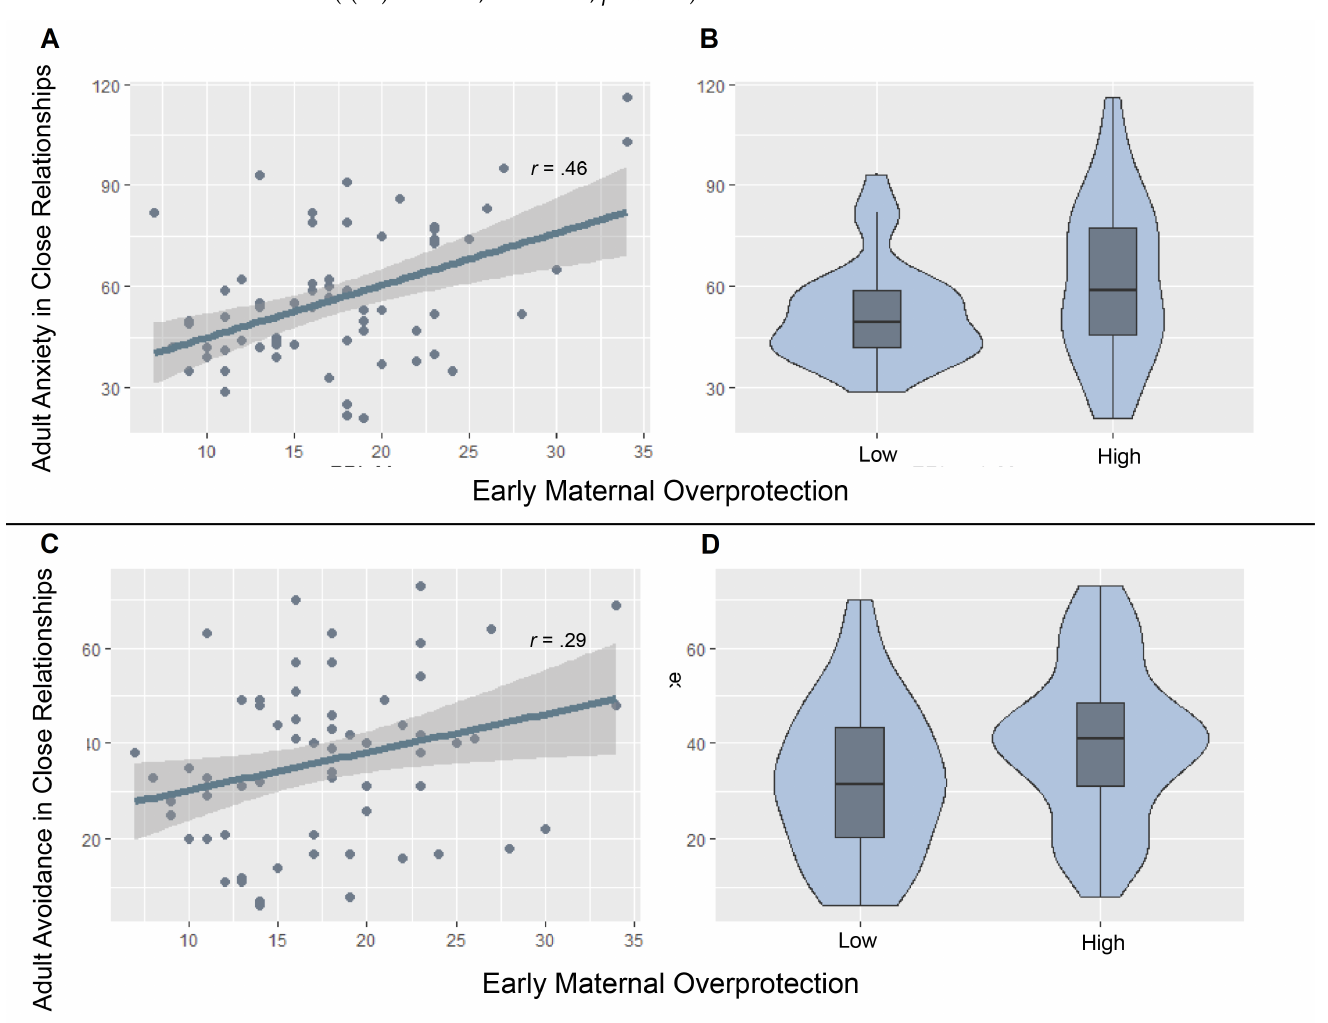
Figure 1. ( A ) Main effect of recalled maternal overprotection in childhood on adult anxiety in close relationships. Pearson r coefficients between the early maternal overprotection and anxiety. The line represents the linear model for the total sample. ( B ) Anxiety mean scores by low and high maternal overprotection. ( C ) The main effect of recalled maternal overprotection in childhood on adult avoidance in close relationships. Pearson r coefficients between the early maternal overprotection and avoidance. The line represents the linear model for the total sample. ( D ) Avoidance mean scores by low and high maternal